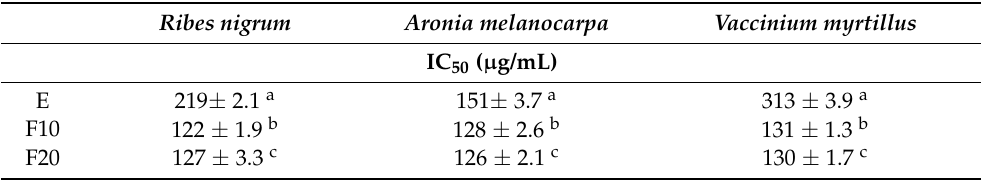
Table 5. Values of IC 50 of ABTS+ radical scavenging for R. nigrum , A. melanocarpa , and V. myrtillus extract and kombucha ferments. Values are mean ± standard deviation (SD) of triplicate. Ribes